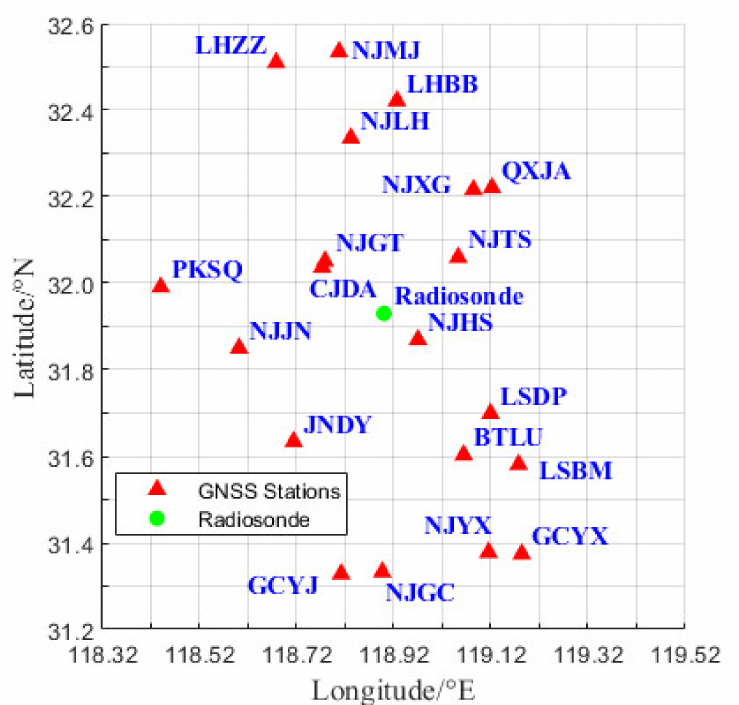
Figure 7. Horizontal grid strategy. The Nanjing area is divided by a 12 × 14 grid in the horizontal domain (14 in the latitudinal direction, 12 in the longitudinal direction). The horizontal resolution is 0.1 ◦ in both the latitude and longitude